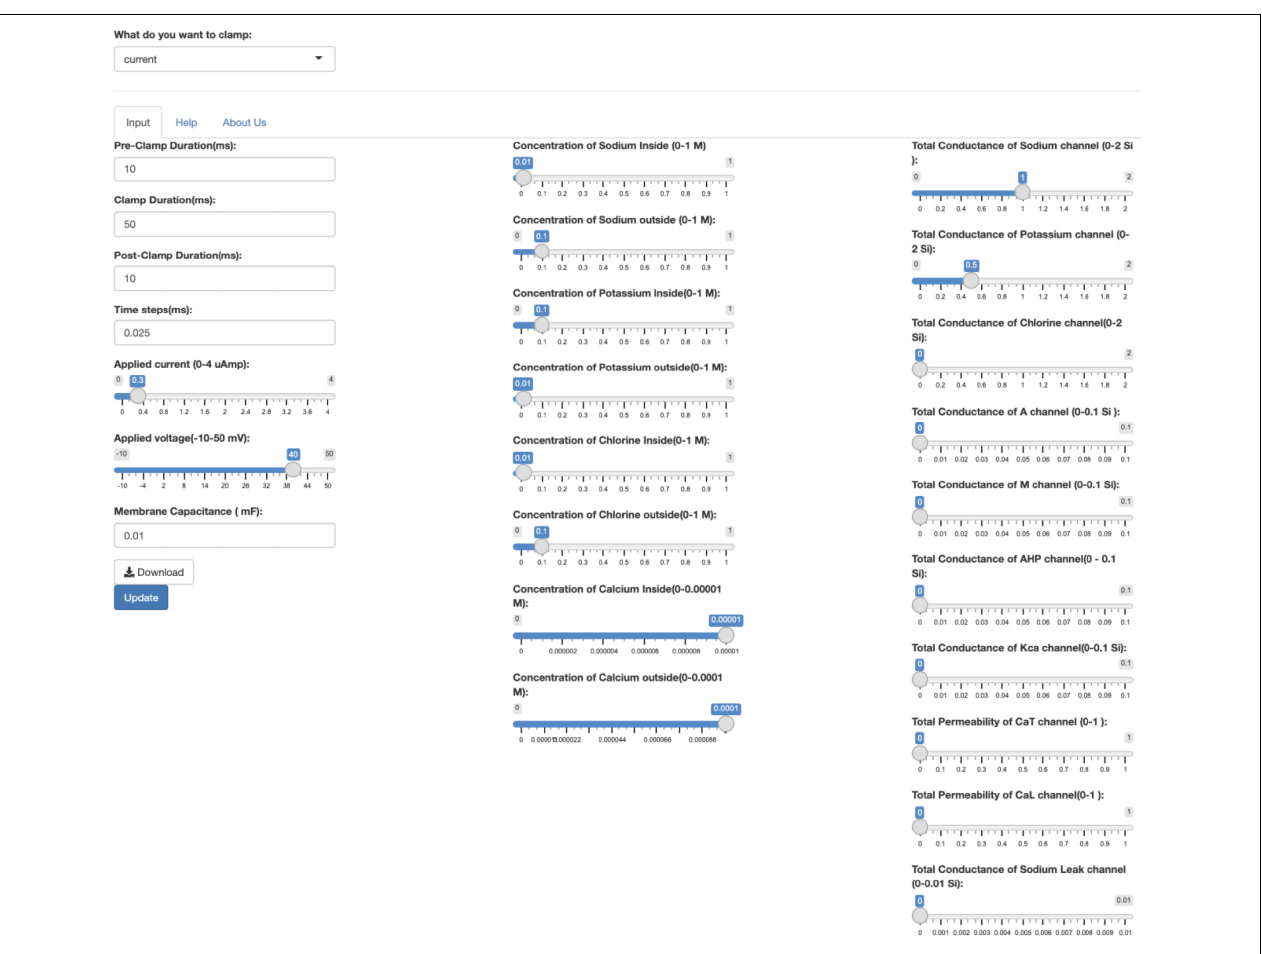
FIGURE 2 | The input controls of the app on a desktop. The user first must select the current clamp or voltage clamp conditions from the drop-down menu. After selecting the clamping conditions, various parameters can be changed using the scrollbar. Pressing the Update button will update the output graphs depending on the values input. The user must click on Update each time they change the parameters. Clicking on the Download button will download the time series voltage, current and conductance of the ion channels in a CSV